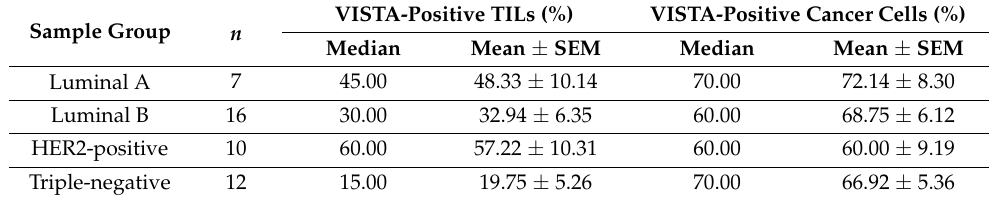
Table 4. Tissue VISTA expression in FFPE samples from FMC, grouped by molecular subtype. Sample